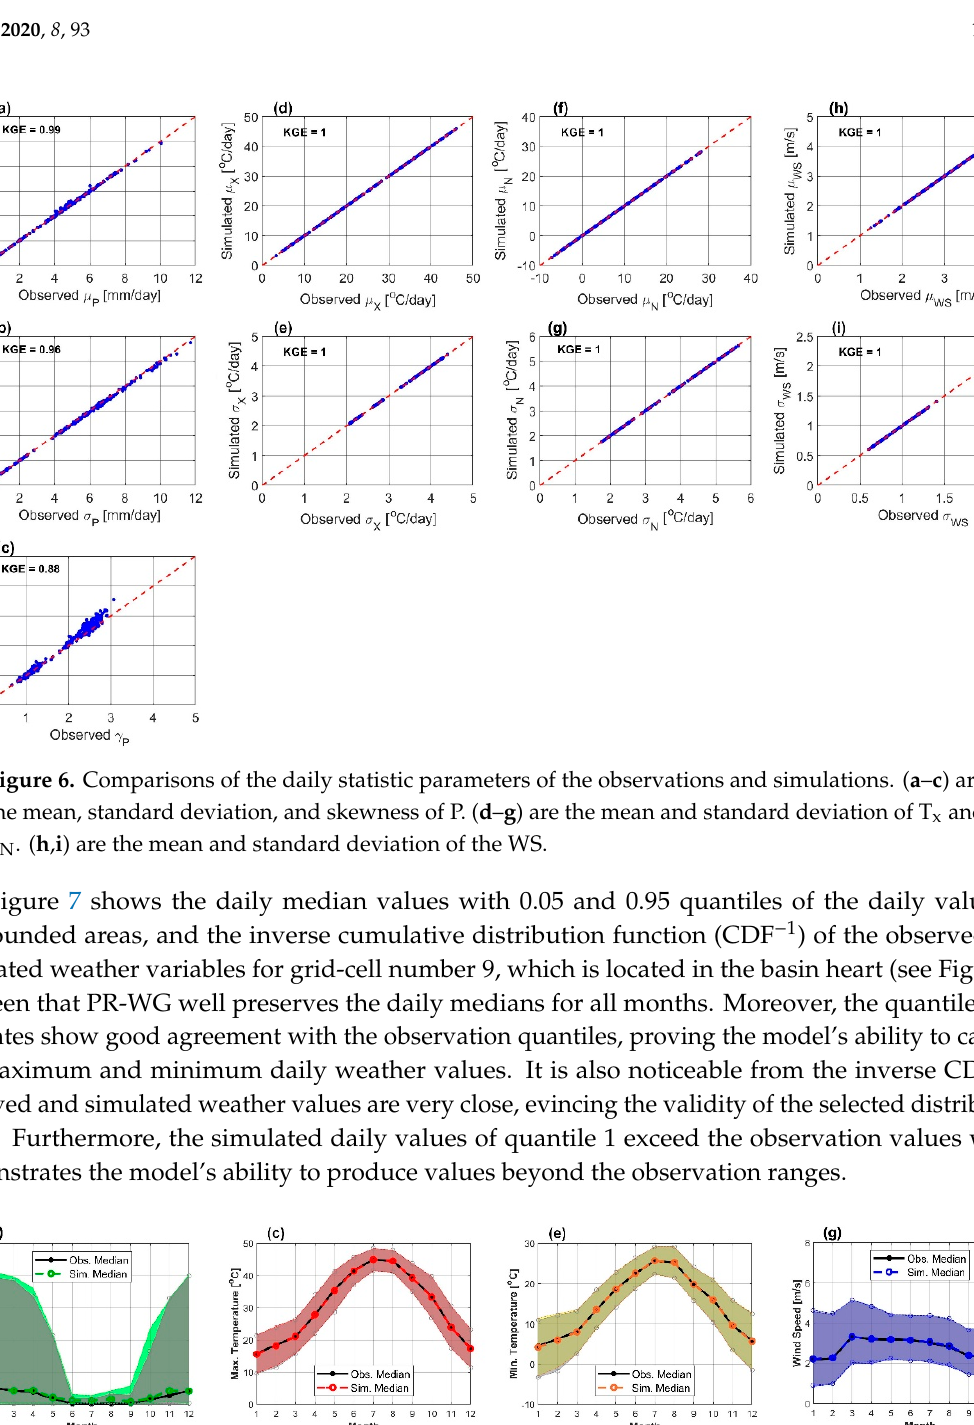
Figure 8. Spatial and cross correlation coefficients of the daily observations (a) and simulations (b) variables.